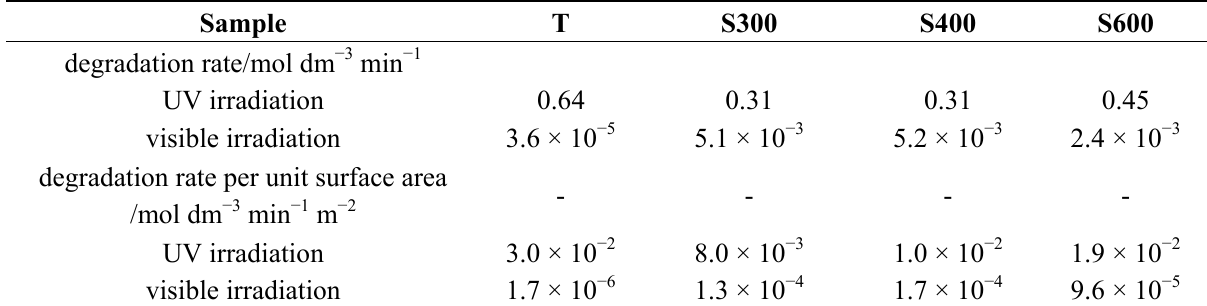
Table 2. Average degradation rates of TCE using the prepared catalysts and those per unit surface area of the